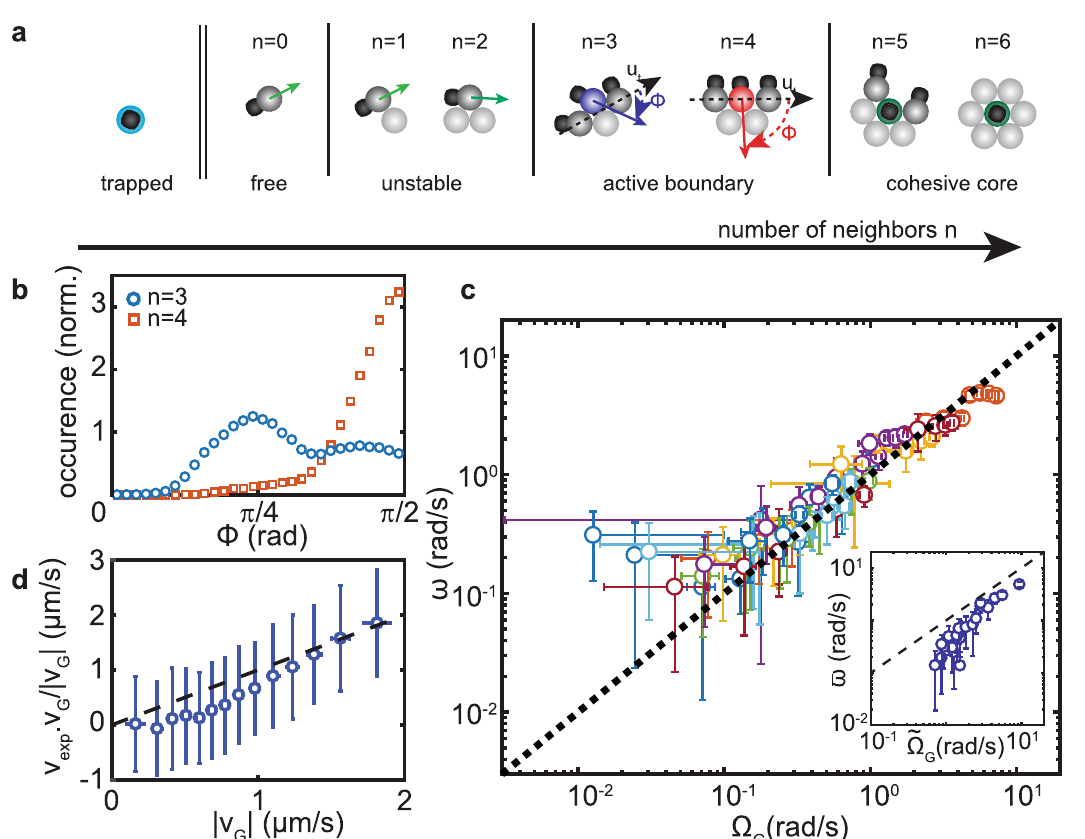
Fig. 3 Pluripotent colloids. a Heterodimers exhibit different functions as a function of their number of neighbors n . Heterodimers stand vertically in an optical trap (light blue). For n = 0 heterodimers navigate freely. For n = 1 or 2, the structure is unstable and the heterodimers detach. For n = 3 (purple) or 4 (red), heterodimers orient with respect to the local tangent u t , with (cid:1) Φ 3 (cid:2) π = 4 and (cid:1) Φ 4 (cid:2) π = 2, respectively, and exert a force along their propulsion direction. For n = 5 or 6 (green), heterodimers are vertical and exert attractive interactions. b Histograms of the angles Φ of heterodimers for n = 3 (blue circles) and n = 4 (red squares) obtained from analysis of slender micromachines of different lengths. c Measured angular velocities ω for 22 different machines (1 color and 4 data points per machine), plotted against the prediction Ω G obtained by tracking of the instantaneous orientation and position of all constitutive swimmers in eq. (2). c Inset, mean value (cid:1) ω plotted against (cid:1) Ω G predicted from our simple model with fi xed orientations Φ ( n = 3) = π /4 and Φ ( n = 4) = π /2 (see main text). d Projected translational speed measured by averaging data from all 22 structures plotted against the predicted translational speed v G from eq. (2). Black dashed lines in ( c ) and ( d ) indicate unity slopes. Error bars are 1 standard